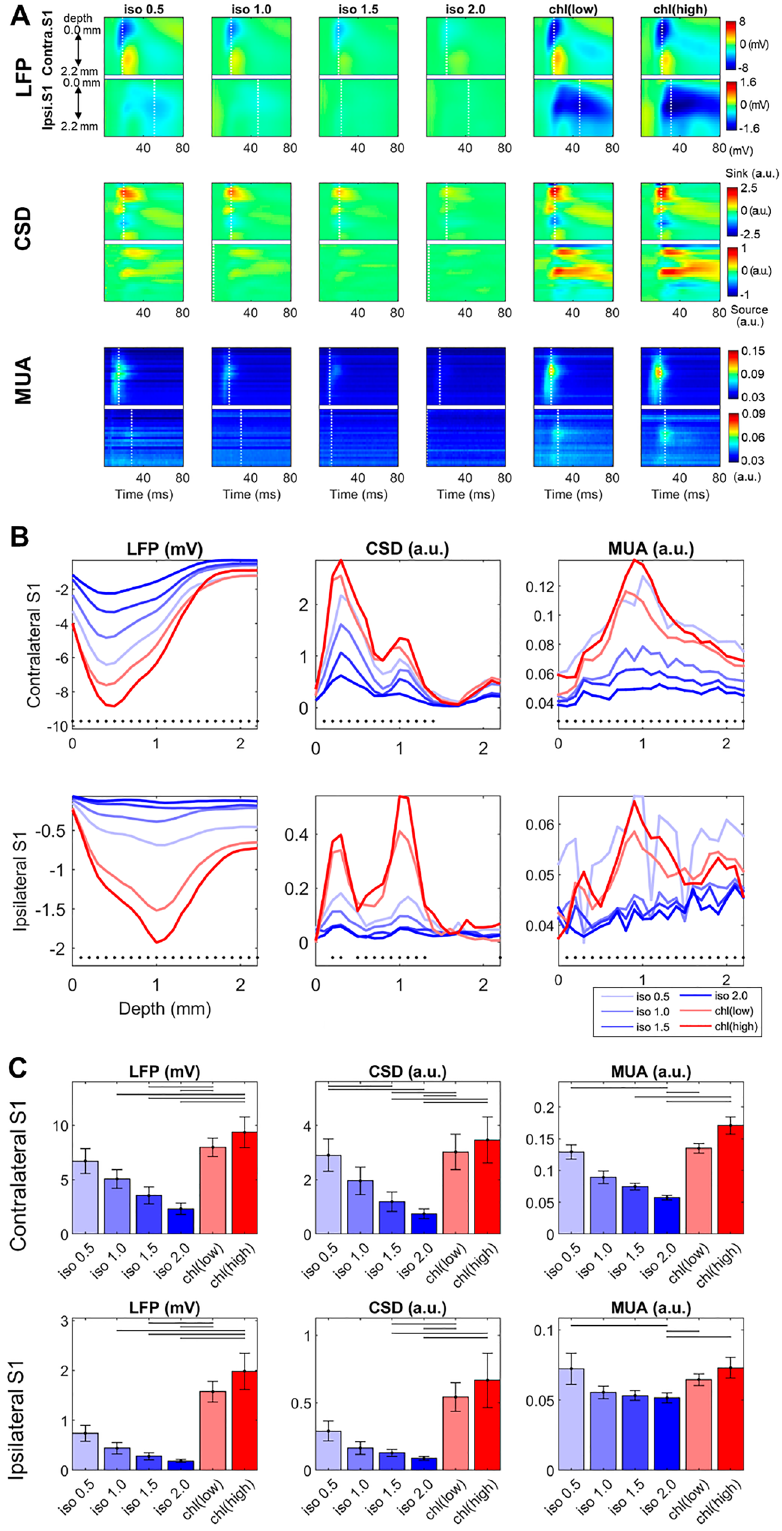
Figure 5. Averaged evoked response to electrical forepaw stimuli (1.0 mA, 0.3 μs duration, 3 Hz for 2 s). ( A ) Spatiotemporal pattern of the sensory-evoked response in the bilateral S1fl. White dotted line: time point with the peak amplitude. ( B ) Peak amplitude in sensory-evoked response in LFP, CSD and MUA (within 0 ~ 50 ms after the forepaw stimulation). Black dots: p < 0.05 in Friedman test. ( C ) Post-hoc comparisons across anesthetic conditions (p < 0.05, Tukey’s test). The highest absolute value in peak amplitudes along the cortical depth were compared. Horizontal bar: p < 0.05 in post-hoc Tukey’s test. (n = 16; 8 rats × 2